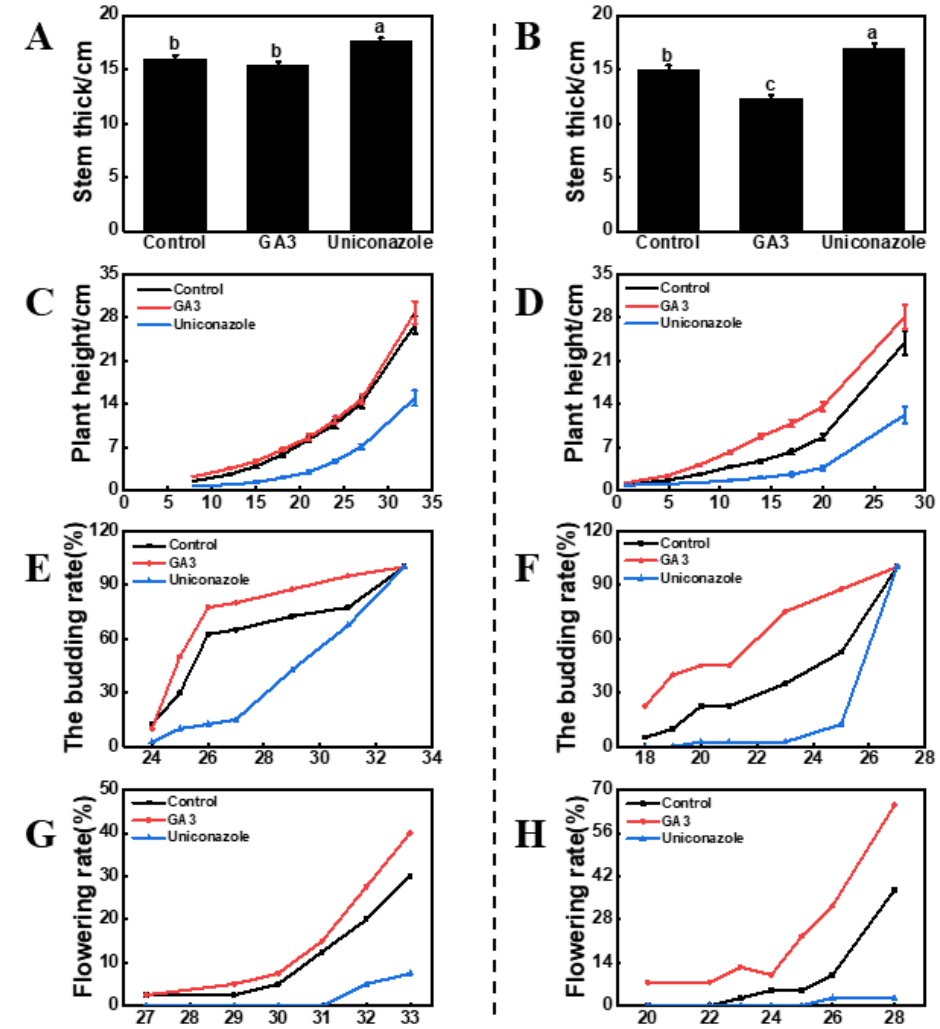
Figure 1. Effect of gibberellin A3 (GA 3 ) and uniconazole spraying on the growth of flowering Chinese cabbage. ( A , B ) are at 33 and 28 days after treatment, respectively, which is also the harvesting period, and we measured the stem thickness. ( A , C , E , G ): two-true-leaf treatment, ( B , D , F , H ): three-true-leaf treatment. The units on the lower axis are the number of days after treatment in ( C – F ). The data represent an average of three replicates ± standard error. Values followed by the same letter are not significantly different using Duncan’s test at p < 0.05.